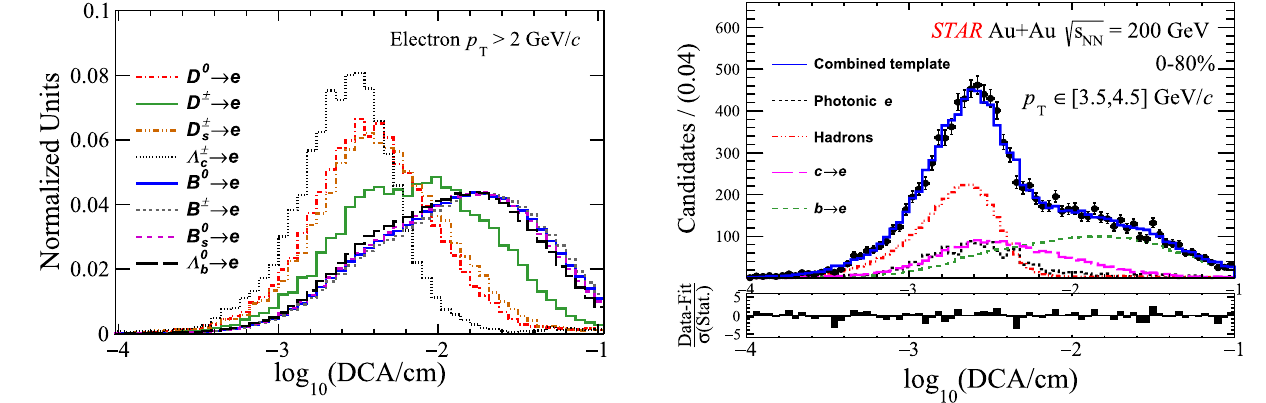
Fig. 5 Fit to the log 10 (DCA/cm) of candidate electrons with p T ∈ [3.5,4.5]GeV/ c in 2014 data. The solid blue line shows the full template fit, and the various other lines show the individual compo- nents. The bottom panel shows the residual distribution of the template fit scaled by the statistical